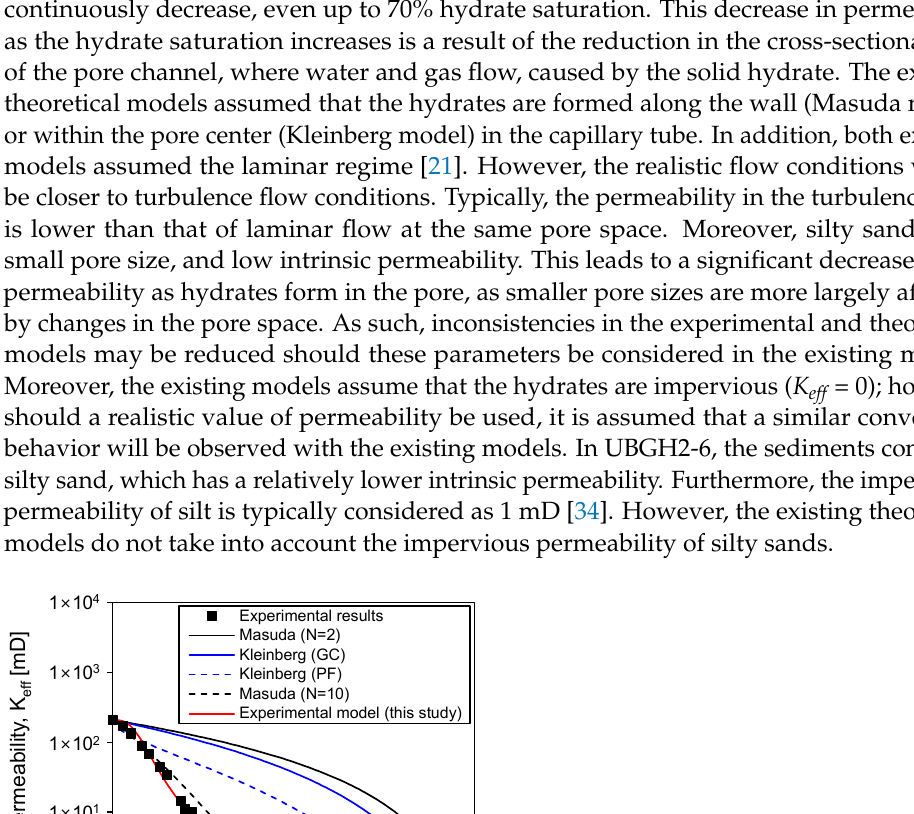
Figure 6. Application of proposed experimental model to the other experimental test data.